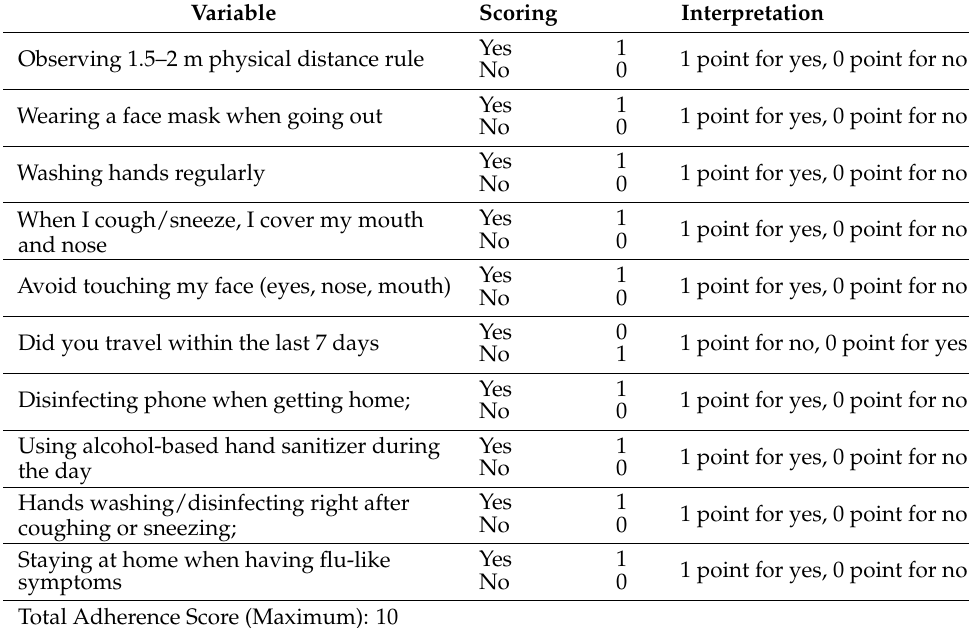
Table 1. Composition of General Adherence score (0–10). Variable